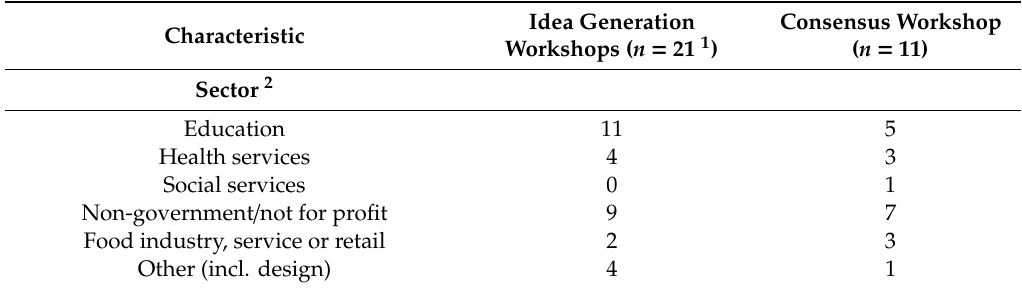
Table 1. Background characteristics of workshop